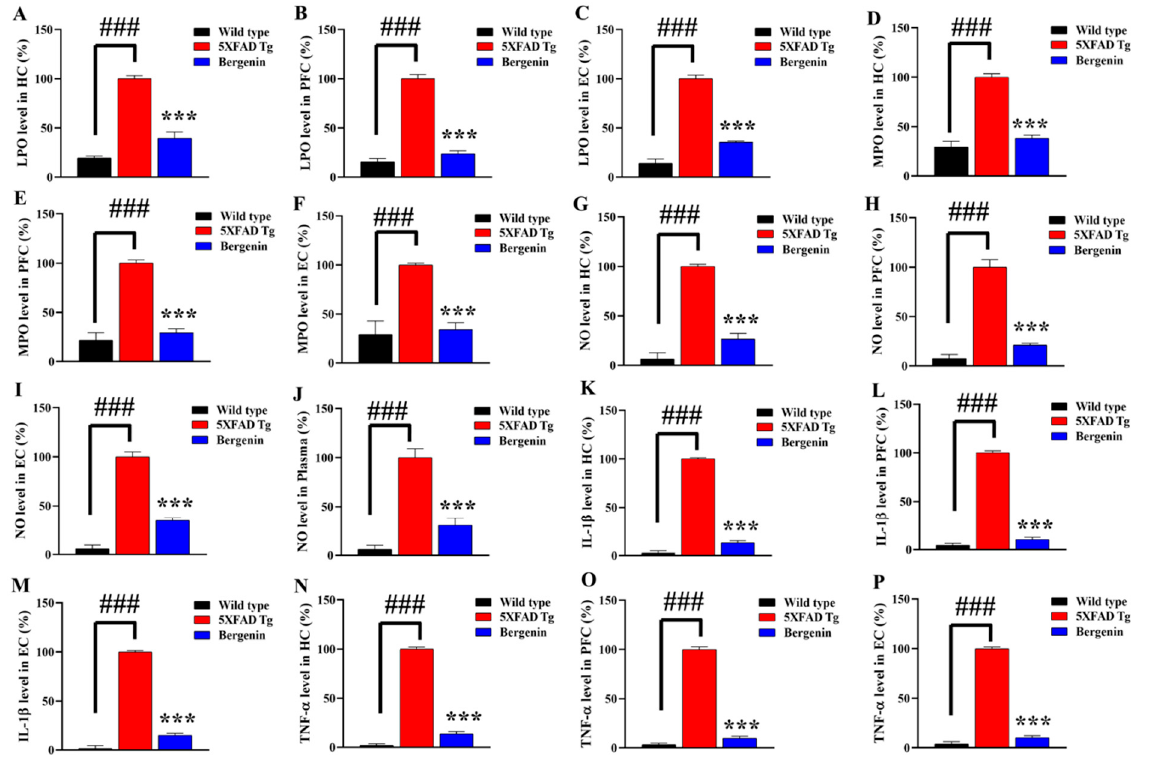
Figure 12. Bergenin ameliorates oxidative stress by decreasing ( A – C ) Lipid peroxidase (%) and ( D – F ) Myeloperoxidase (%) level in HC, PFC and EC regions of the mouse’s brain. Similarly, % Nitrite production in ( G ) HC, ( H ) PFC, ( I ) EC regions and ( J ) plasma of the mice were observed to be decreased with Bergenin treatment. Bergenin (60 mg/kg) displayed an inhibitory effect on pro-inflammatory cytokines ( K – M ) IL-1 β , and ( N – P ) TNF- α production in HC, PFC and EC regions of mouse brains in wild-type, 5xFAD Tg and Bergenin groups. Results were expressed as mean ± S.D. *** p < 0.001 versus the transgenic (5xFAD Tg) mice group, ### p < 0.001 versus the wild type.